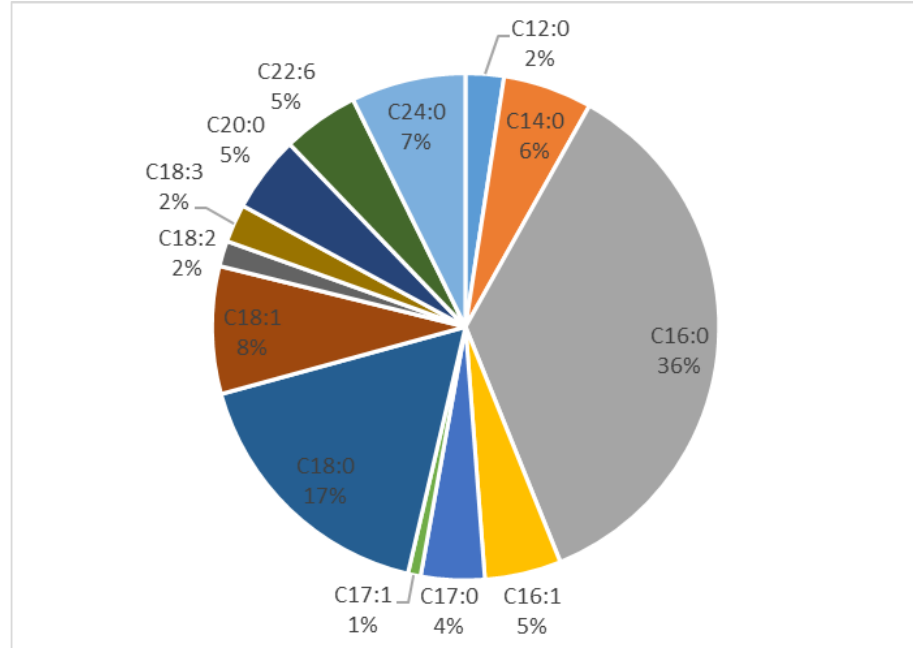
Figure 2. Relative average contents of RJ common long-chain FAs.